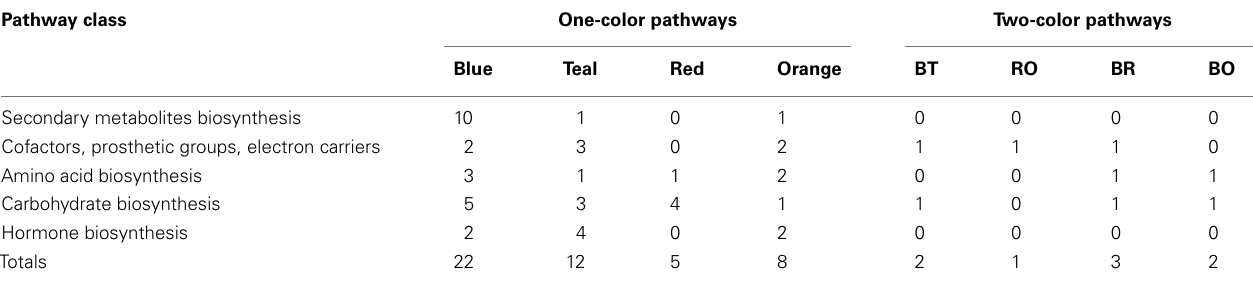
Table 1 | Five metabolic pathway classes showing affects by Mu killer in common or different from Mu inactive lines. Pathway